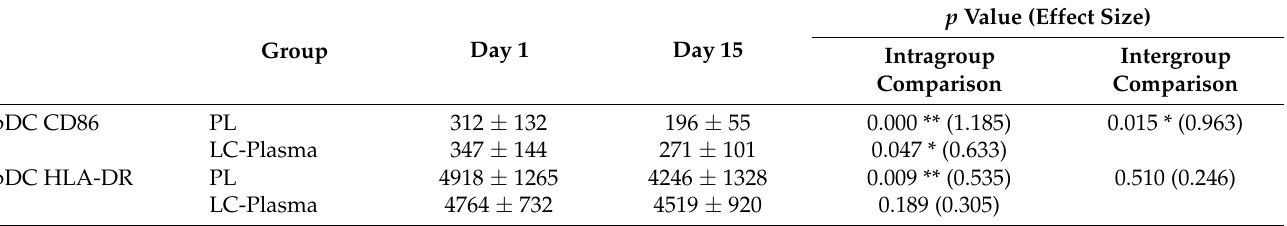
Table 2. The expression intensities of cell surface molecules CD86 and HLA-DR as the DC activity marker on days 1 and 15.